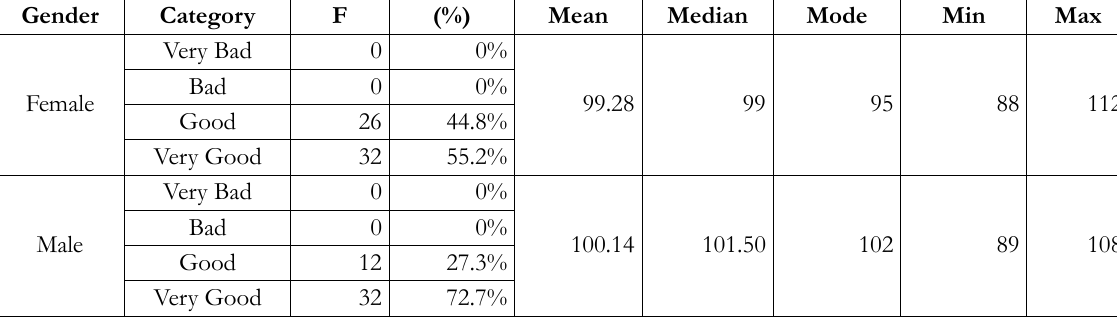
Table 9. Ninth Grade Student’s Perception of the Use of Web-based Character